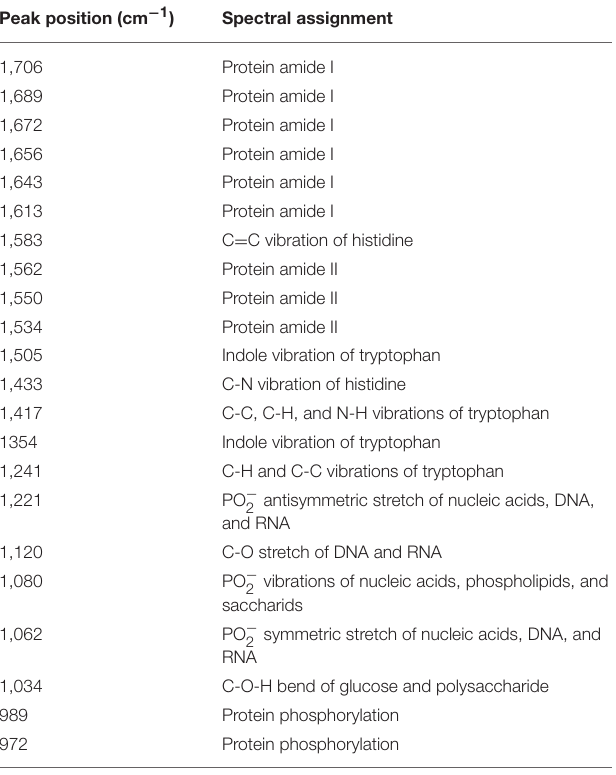
TABLE 1 | Spectral assignment for the observed peaks in the PLS-DA regression coefficient plot. Peak position (cm − 1